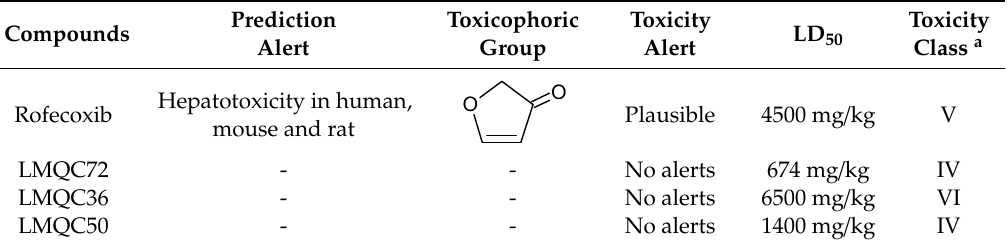
Table 8. Predictions of the toxicological properties the selected compounds.